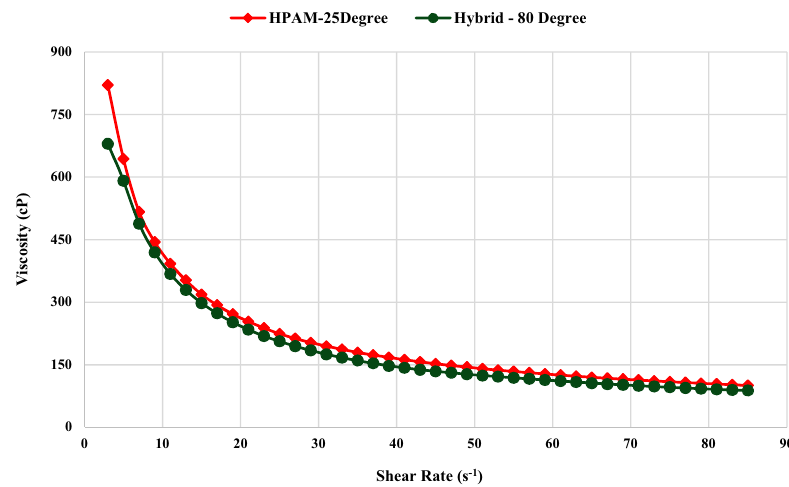
Figure 7: Comparison of shear viscosity of polymer sample ( at 25°C ) and hybrid sample ( at 25°C )